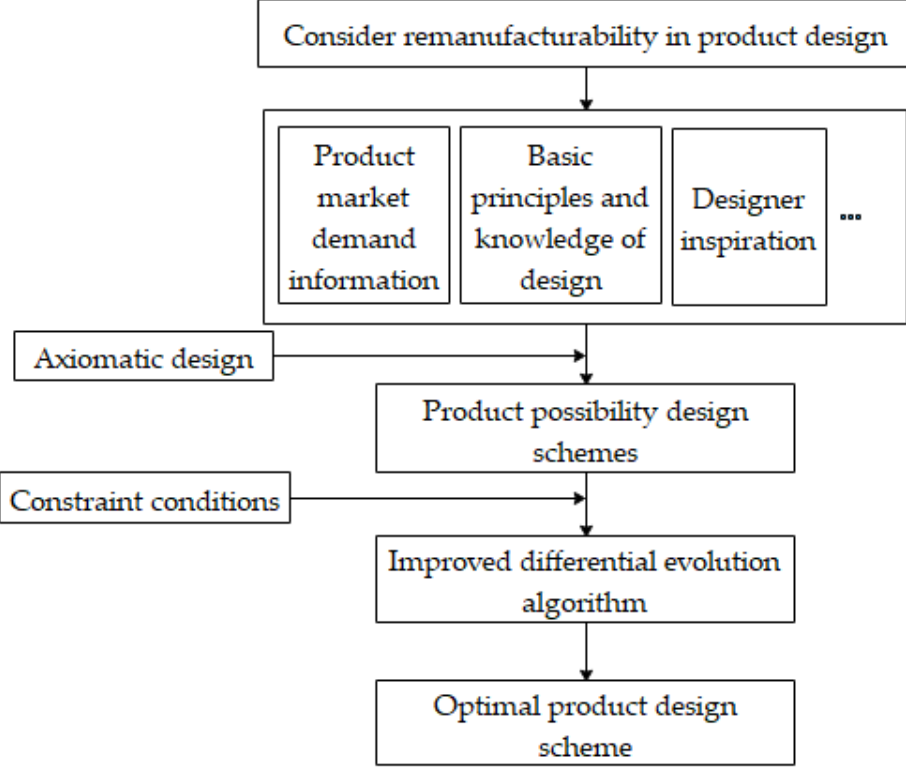
Figure 1. Product design optimization process while considering remanufacturing.